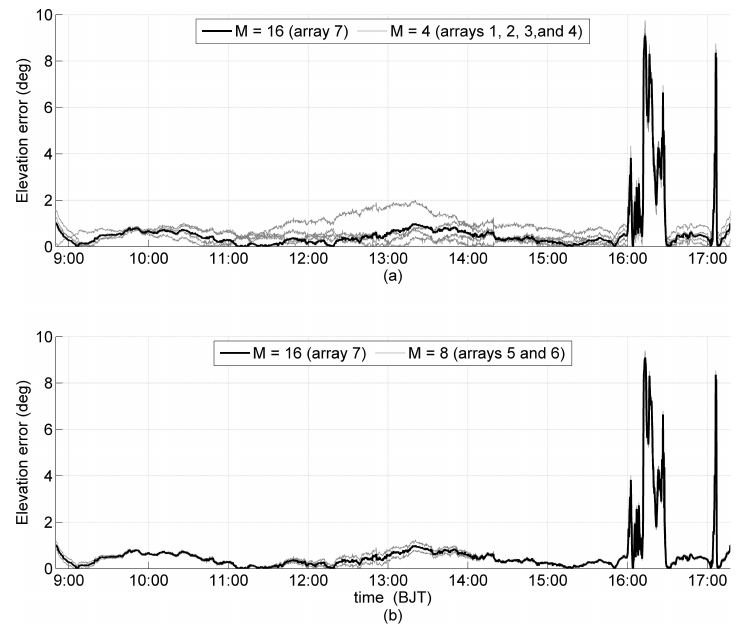
Figure 9. Experimental errors of the solar elevation angle, with a thick black line generated by Array ( M = 16), and thin gray lines generated by: ( a ) Arrays 1, 2, 3, and 4 ( M = 4); and ( b ) Arrays 5 and 6 ( M =